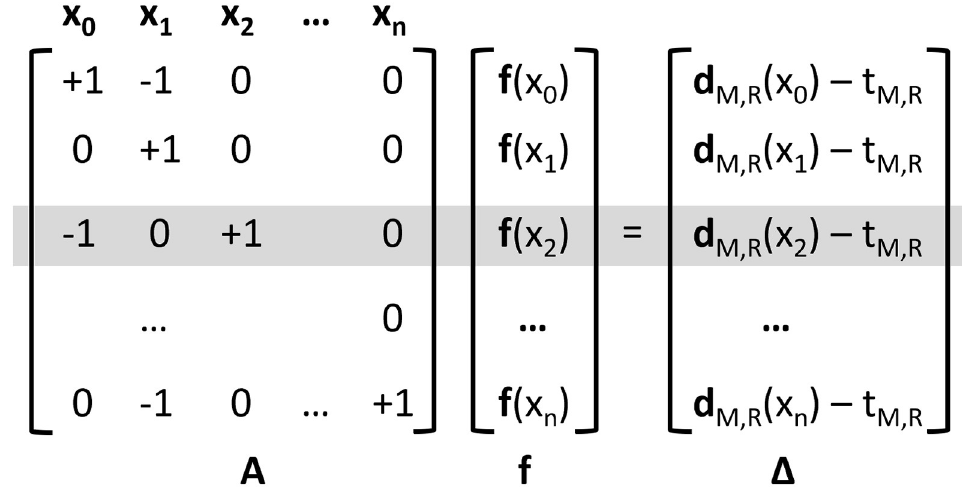
Fig 2. Linear algebra representation required to solve for the static distortion function f(x). A sparse array (A) populated by entries of ± 1 is used to perform pairwise difference operations between image pixels x i for the distorting function f(x). The resulting “paired functional differences” are given in Δ . This array is equivalent to the vector required to register the two images (d M,R ), after accounting for the scalar whole-field translation between the images t. The unknown values f(x) can then be solved by pseudoinversion of the large, sparse matrix A. The highlighted row corresponds to the example depicted in Table 1 and in Fig 1.